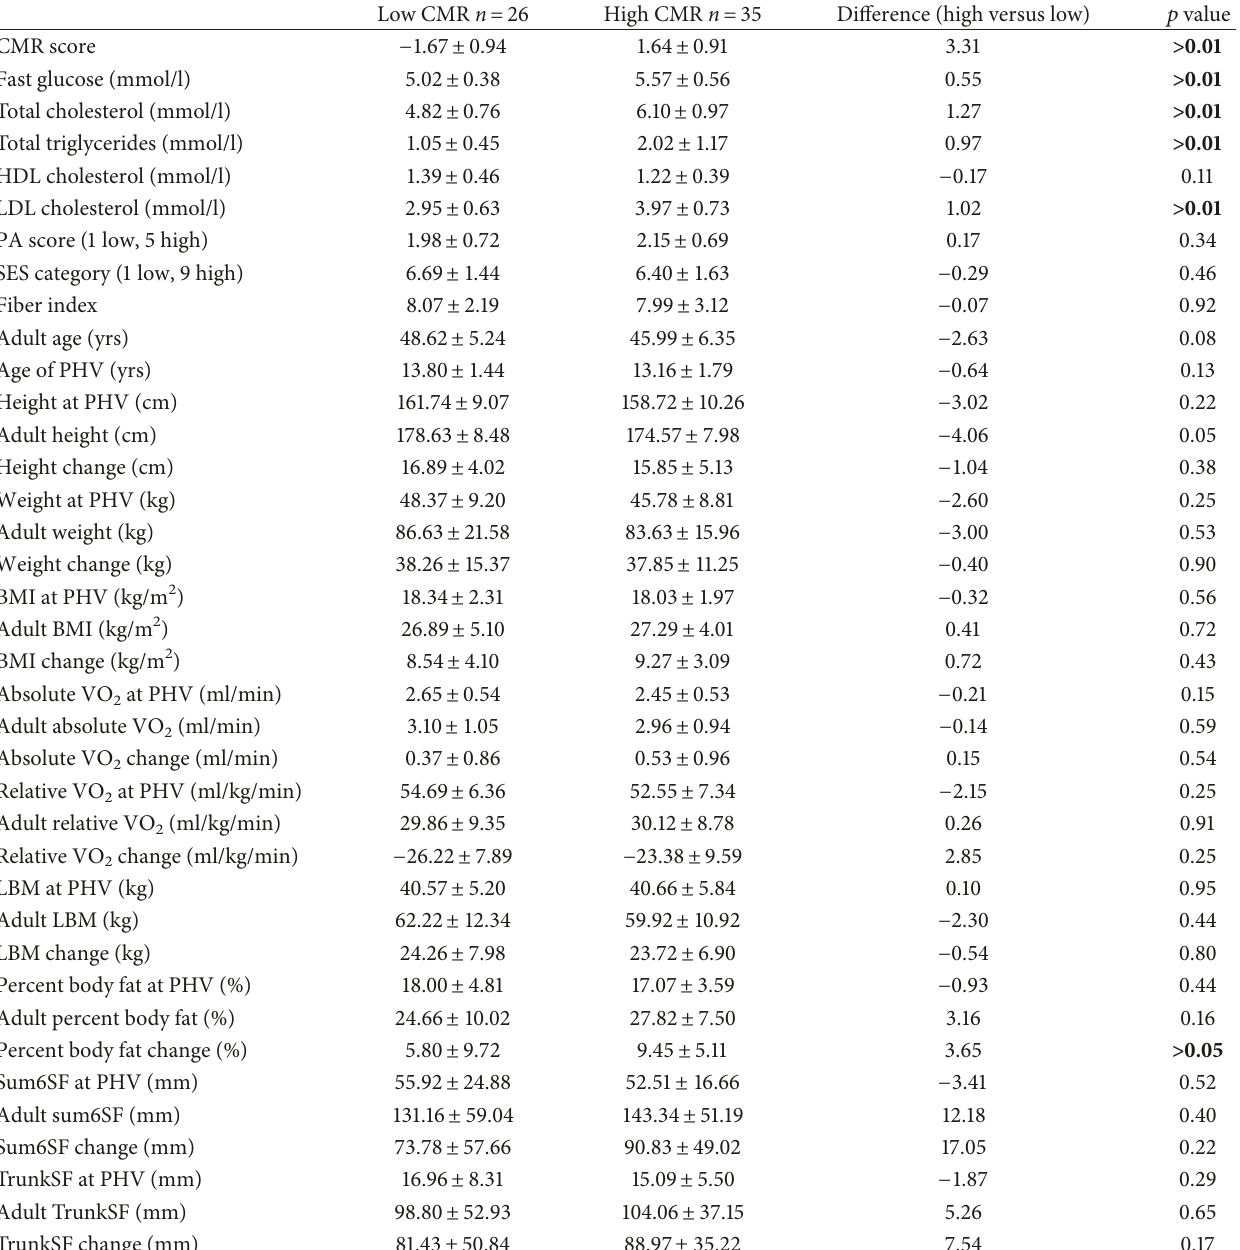
Table 1: Descriptive variables for participants categorized as having low and high adult cardiometabolic risk. Presented as mean ± standard